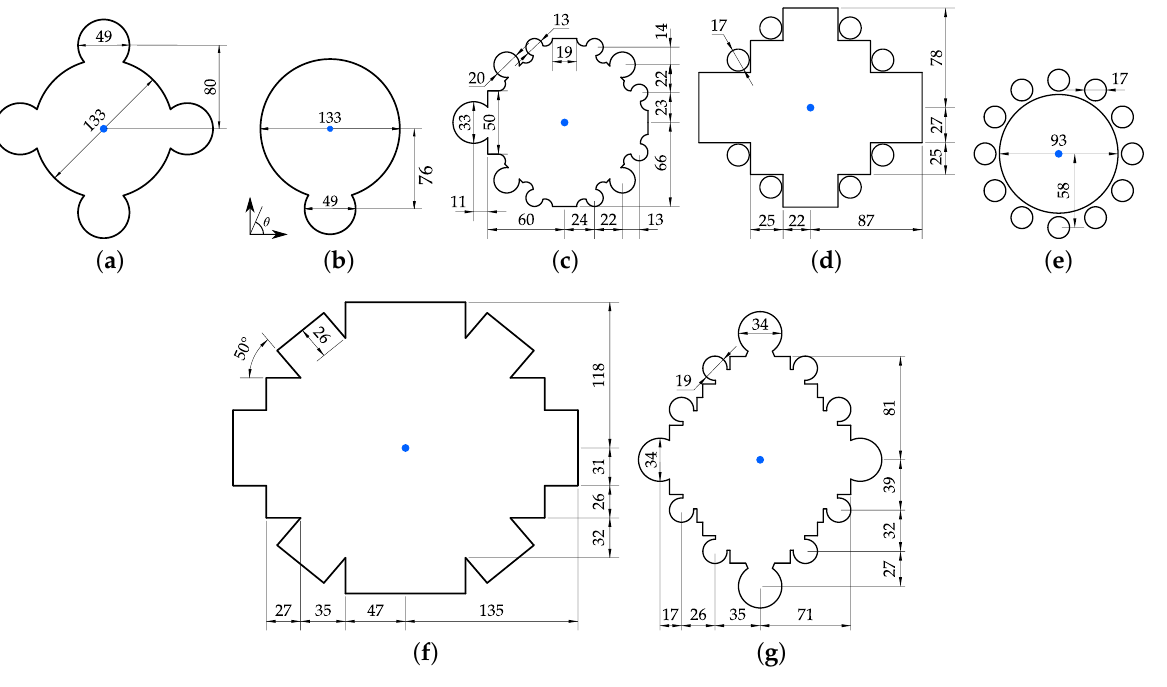
Figure 3. Cross-sections of the selected shafts. Piers of the western bay of the nave, ( a ) N1 , ( b ) N2 . Pier ( c ) Ch in the southern ambulatory. Piers with detached colonnettes ( d ) C1 , western wall of the transept, and ( e ) N3 , nave aisles. Western crossing piers ( f ) C1 at the arcade level. Piers ( g ) T , supporting the tribune between the towers. Dimensions are given in cm. A cylindrical coordinate system is assigned to each, centered on the blue point, and the directions of propagation of the incident waves are indicated with respect to the abscissa, as shown in ( b ) in the